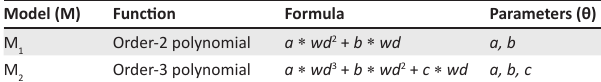
TABLE 2: Vulnerability analysis functions.